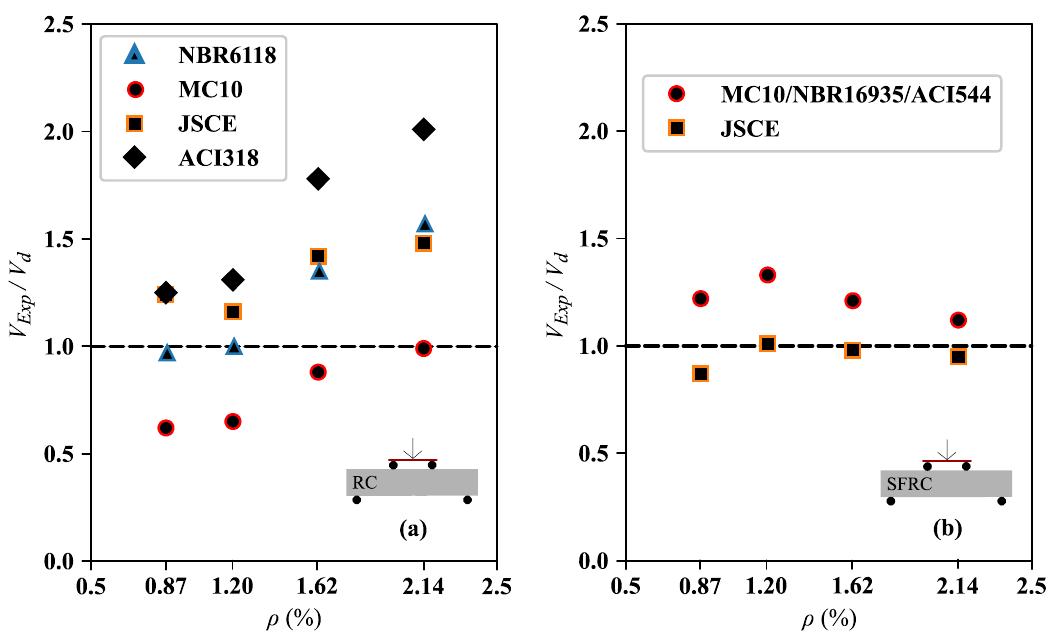
Figure 13. Relationship between experimental and shear strength estimates: (a) With the series of beams without fiber and (b) With the series of beams with fiber.